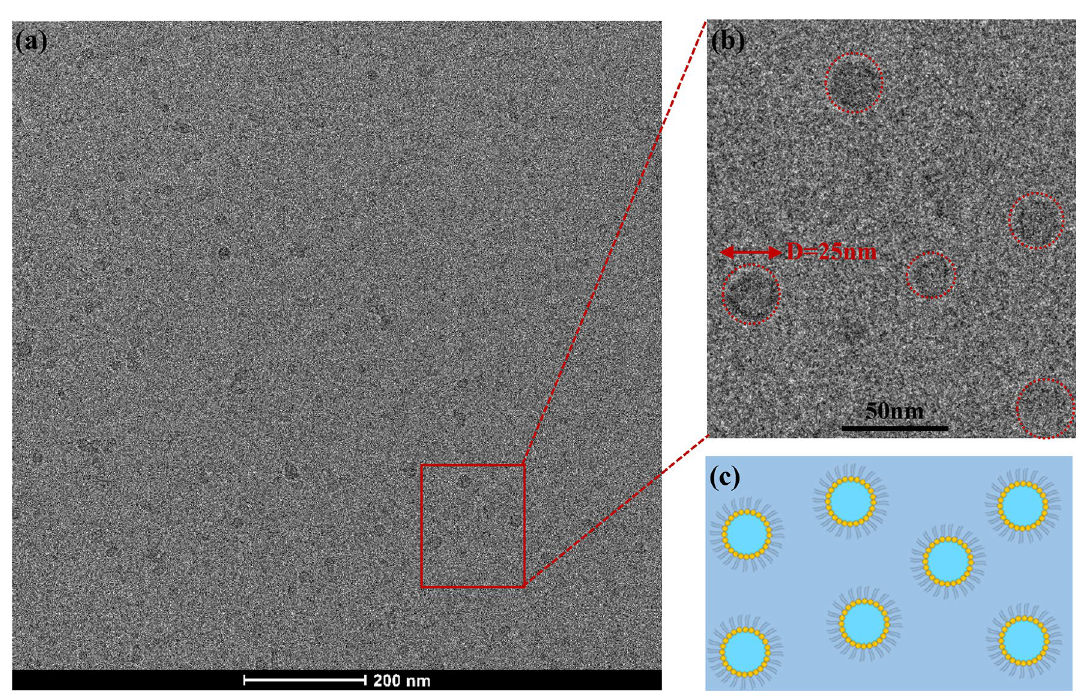
Figure 6. The cryo-TEM images of the microemulsion BT: ( a ) low magnified image, ( b ) high magnified image and ( c ) the schematic illustration of the microemulsion